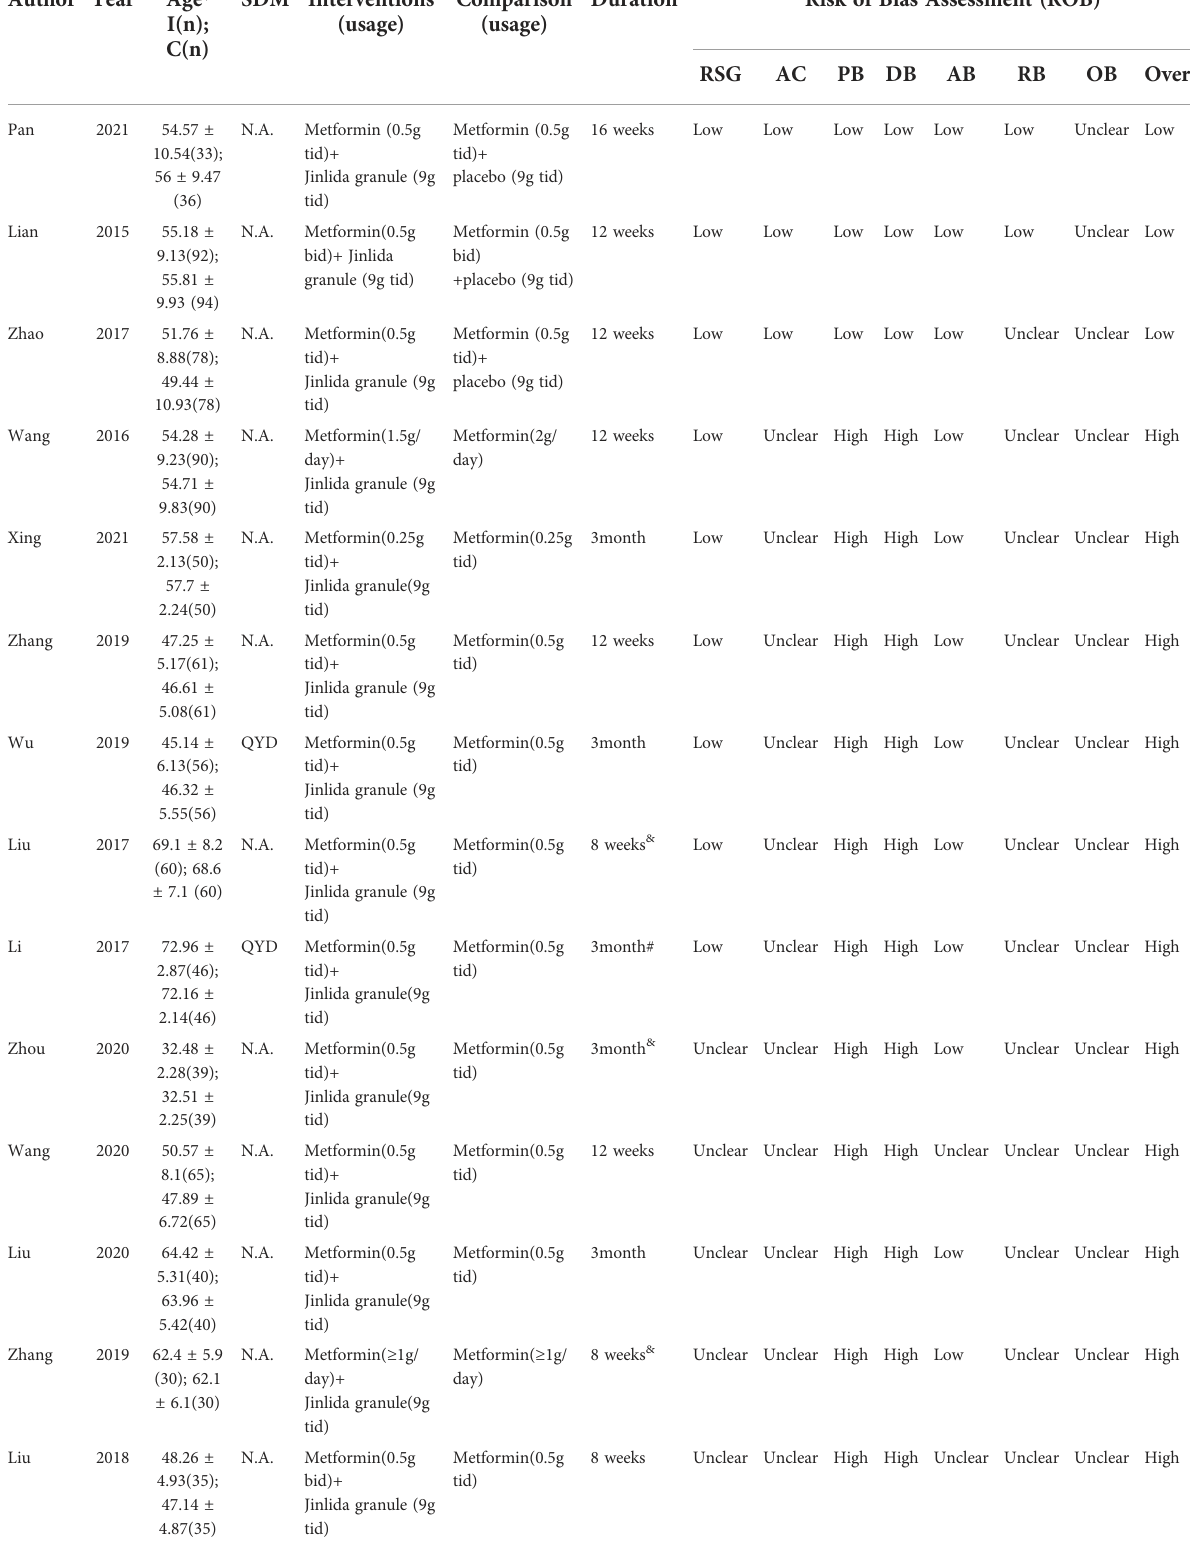
TABLE 1 The main information and risk of bias assessment of the included RCTs. Author